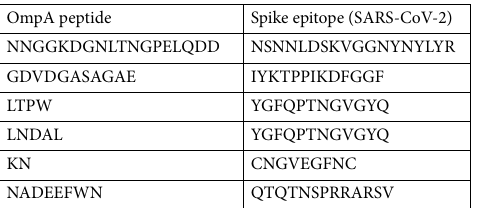
Table 1. Loops and internal turns of OmpA β-barrel replaced by the selected epitopes of S 437-806